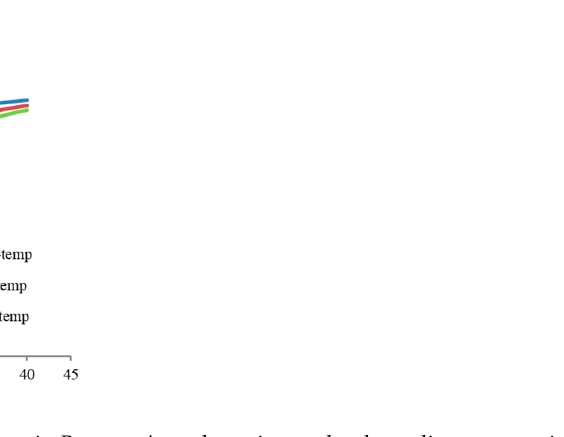
Figure 9. Growing process of carbon storage in P. massoniana plantation under three climate scenarios.